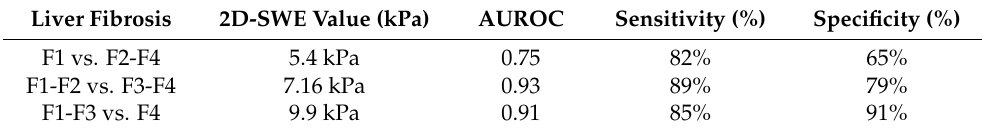
Table 3. 2D-SWE threshold values defining different liver fibrosis stages.